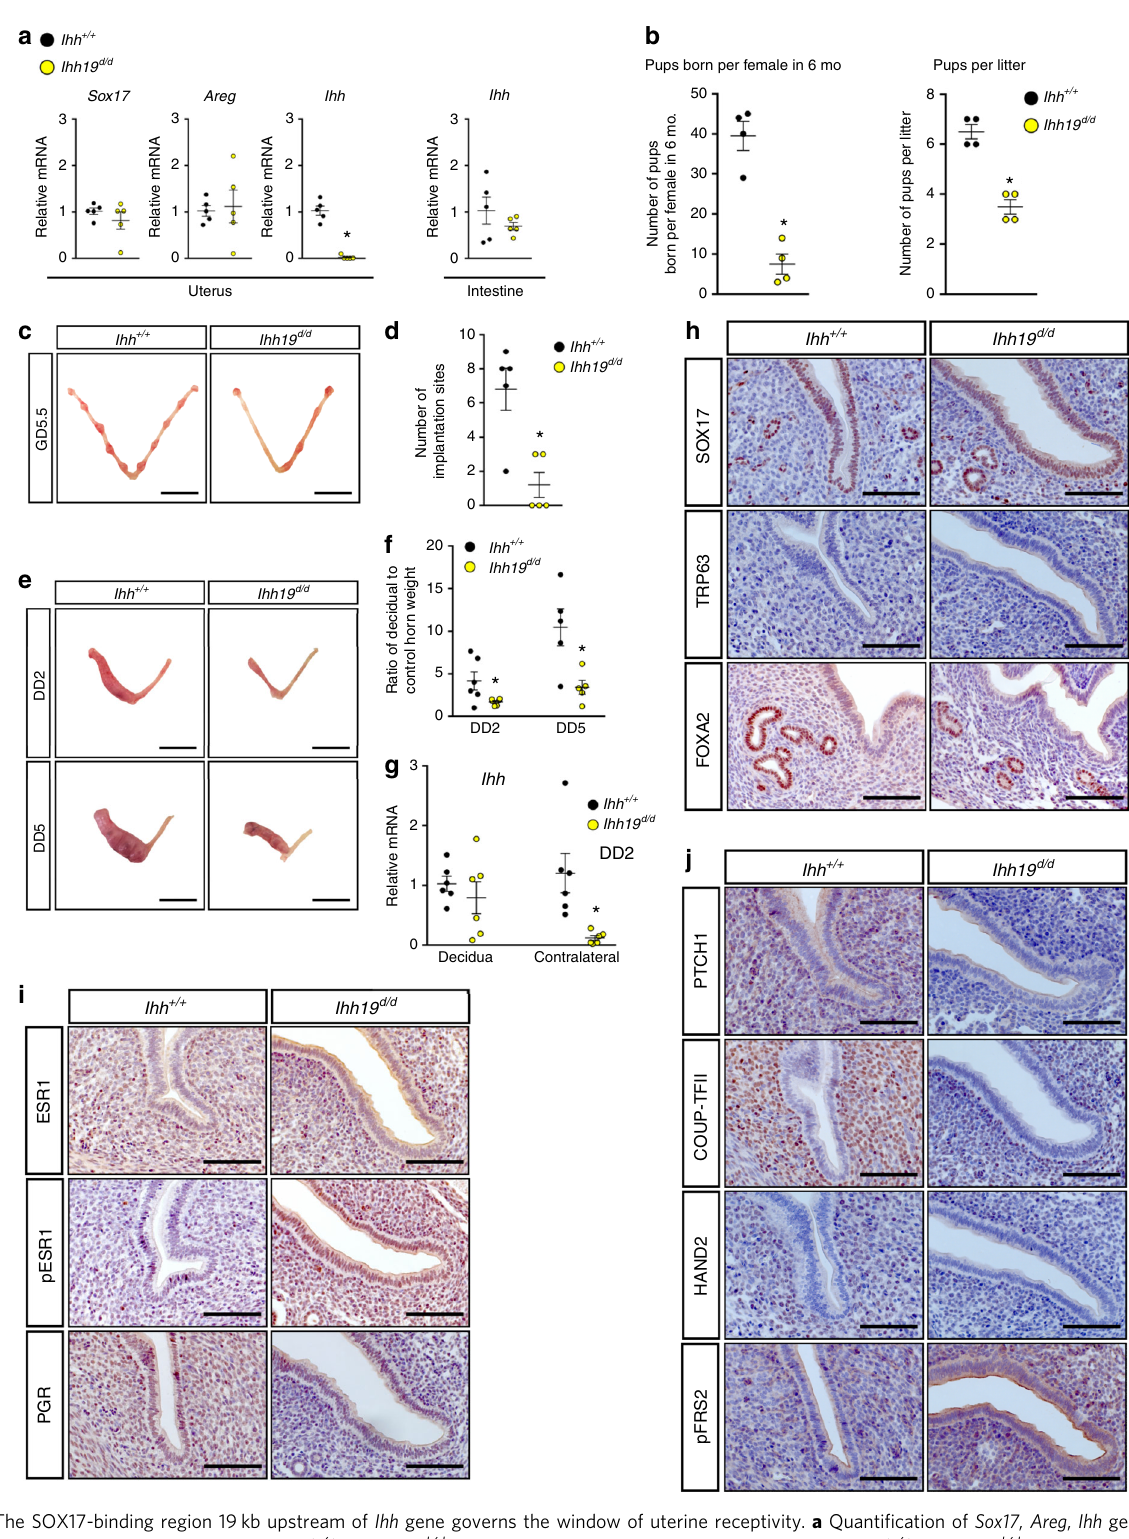
Fig. 7 The SOX17-binding region 19 kb upstream of Ihh gene governs the window of uterine receptivity. a Quanti fi cation of Sox17 , Areg , Ihh gene expression in uteri and/or intestine from Ihh + / + and Ihh19 d/d female mice at GD2.5 ( n = 5). b Pups born from Ihh + / + and Ihh19 d/d female mice during 6- month breeding trial ( n = 4). c , d Embryo implantation sites ( c ) and quanti fi cation ( d ) in uteri from Ihh + / + and Ihh19 d/d female mice at GD5.5 ( n = 5). Scale bars: 10 mm. e , f Arti fi cial deciduoma formation ( e ) and ratio of decidual to control horn weight ( f ) in Ihh + / + and Ihh19 d/d female mice at DD2 ( n = 6) and DD5 ( n = 5). Scale bars: 10 mm. g Quanti fi cation of Ihh gene in decidual and contralateral horn from Ihh + / + and Ihh19 d/d female mice at DD2 ( n = 6). h - j Immunohistochemical staining of SOX17, TRP63, FOXA2, ESR1, pESR1, PGR, PTCH1, COUP-TFII, HAND2, and pFRS2 in GD 3.5 uteri from Ihh + / + and Ihh19 d/d mice ( n = 3). Scale bars: 100 µ m. Black dots denote Ihh + / + and yellow dots denote Ihh19 d/d . * P < 0.05 (Student ’ s t test for a , b , d , and ANOVA with Tukey ’ s post hoc test for f , g ). Data are presented as means ±